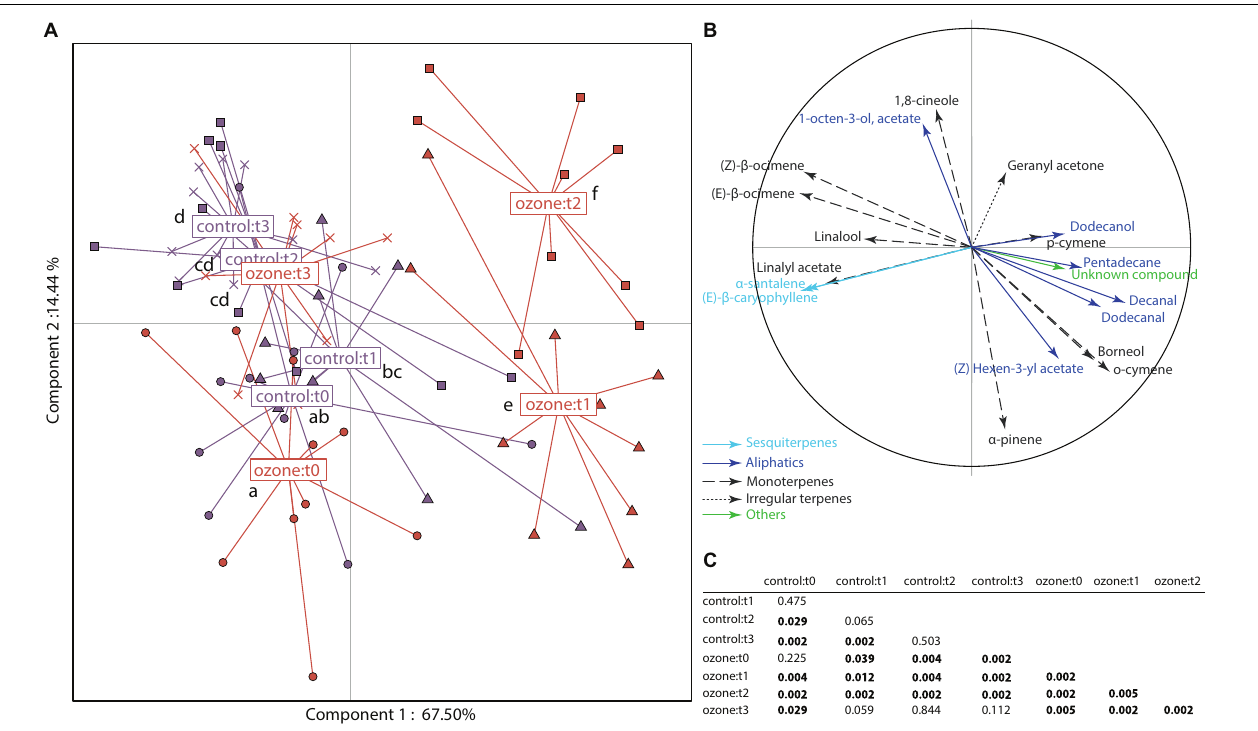
FIGURE 3 | Partial Redundancy Analysis (pRDA) score plot from the constrained Principal Component Analysis of the relative proportions of flowering lavender volatile organic compounds (VOCs) in chambers as a function of treatment and time of day for experiment 1 (A) and the associated correlation circle (B) . Red symbols on the score plot correspond to the odor bouquet of “ozone” lavenders, purple symbols correspond to that of “control” lavenders; and symbols indicate the time of the VOCs collection in the chambers (circle = t0, triangle = t1, square = t2, cross = t3). Groups with different letters next to the barycenters show statistically significant different chemical profiles, as detailed in table (C) , presenting the p -values of the permutation test assessing pairwise comparisons for different modalities of the treatment and time. Significant differences ( p < 0.05) are indicated in